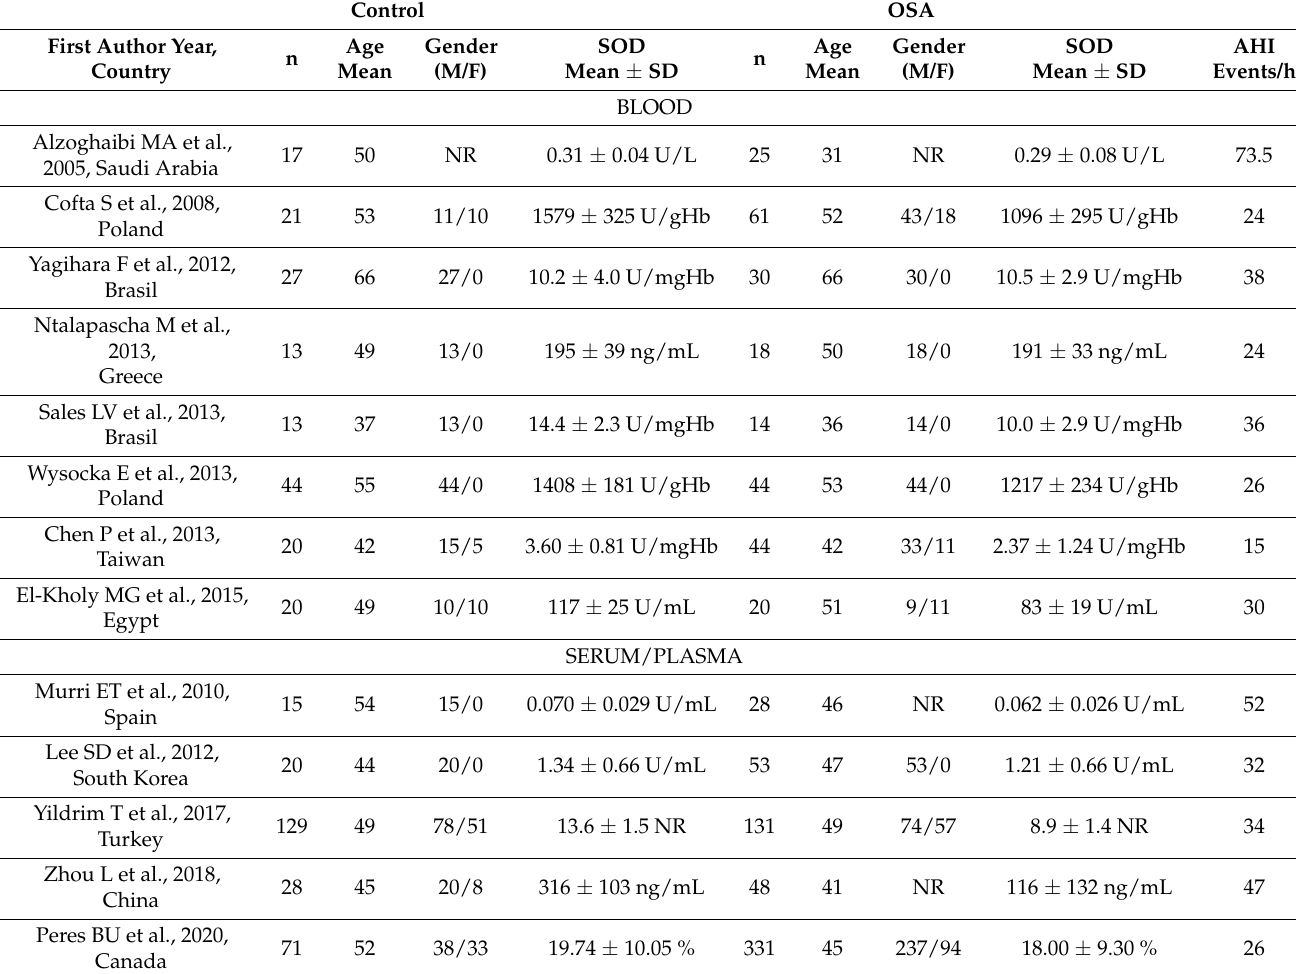
Figure 2. Flow chart of study selection. Table 1. Summary of the studies on controls vs. OSA subjects included in the meta-analysis. Control OSA Control